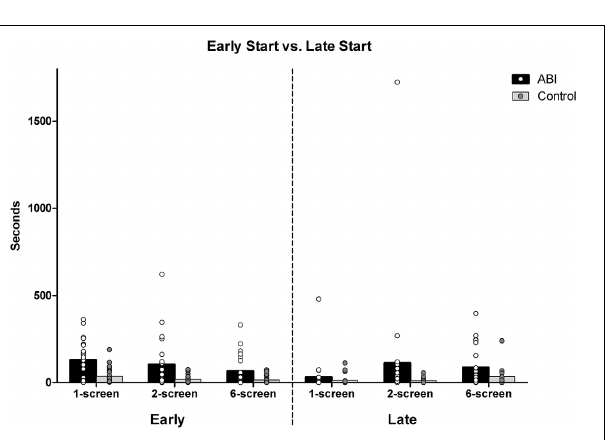
FIGURE 7 | Average early and late start deviations in